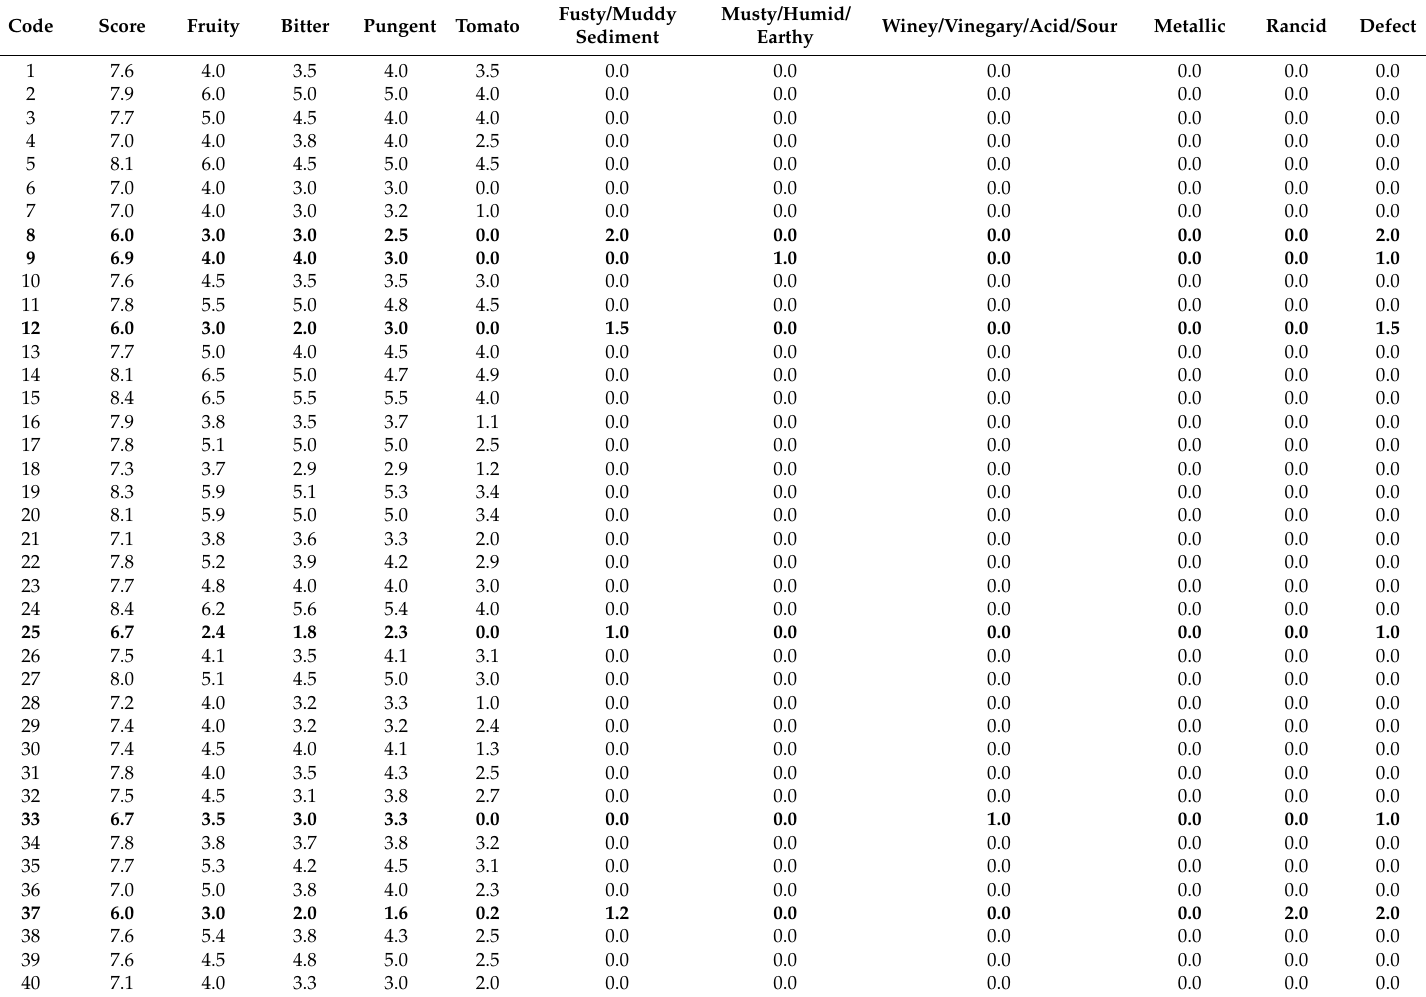
Table 1. Sensory profiles of olive oils. The defective samples are reported in bold